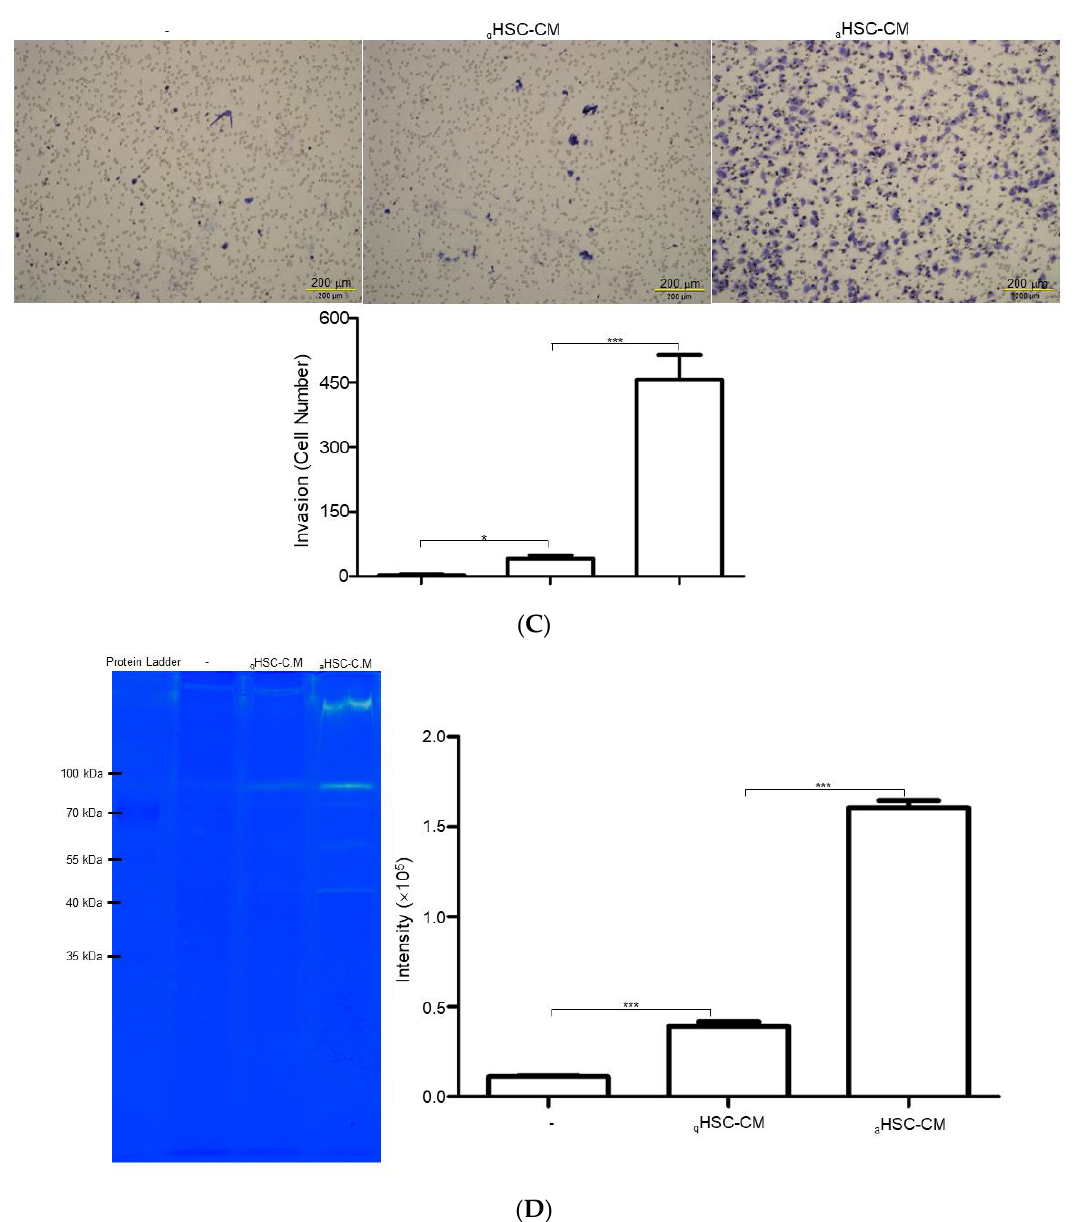
Figure 2. The efficacy of HSC-CM upon HCC J5 cells. ( A ) Validation of the changes of protein levels in HSCs treated with or without TGF- β1 and J5 cells exposed to aHSC-CM or qHSC-CM through Western blot analysis. GAPDH was used as the loading control. The quantified results were indicated by the bar chart (* p < 0.05, *** p < 0.001). ( B ) aHSC-CM administration enhanced wound closure. Representative phase-contrast micrographs of scratch-wounded confluent cultures with regular DMEM ( − ), qHSC-CM, and aHSC-CM-treated J5 cells at 0, 24, 48, and 72 h post-wounding (* p < 0.05, *** p < 0.001, n.s. indicated no significance). ( C ) A marked increase in cell invasion was observed in the human liver cancer J5 cells treated with aHSC-CM, compared to that of regular DMEM ( − ) and qHSC-CM ( bar scale 200 μ m). A comparison of the number of transmembrane cells indicates 88% enhancement after the administration of aHSC-CM. The quantified results were demonstrated by the bar chart and represent the mean ± SD of three independent experiments (* p < 0.05, *** p < 0.001). ( D ) Gelatin zymographic assay was performed using the medium of J5 cells treated with regular DMEM ( − ), qHSC-CM, and aHSC-CM. The quantitative results were shown as bar charts (*** p < 0.001).